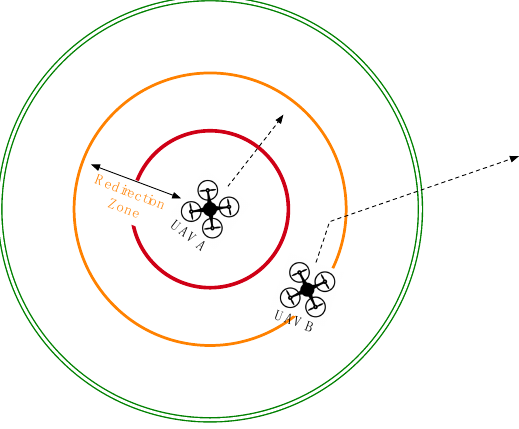
Figure 4. Case 3: change flight path of UAV in the redirection zone.